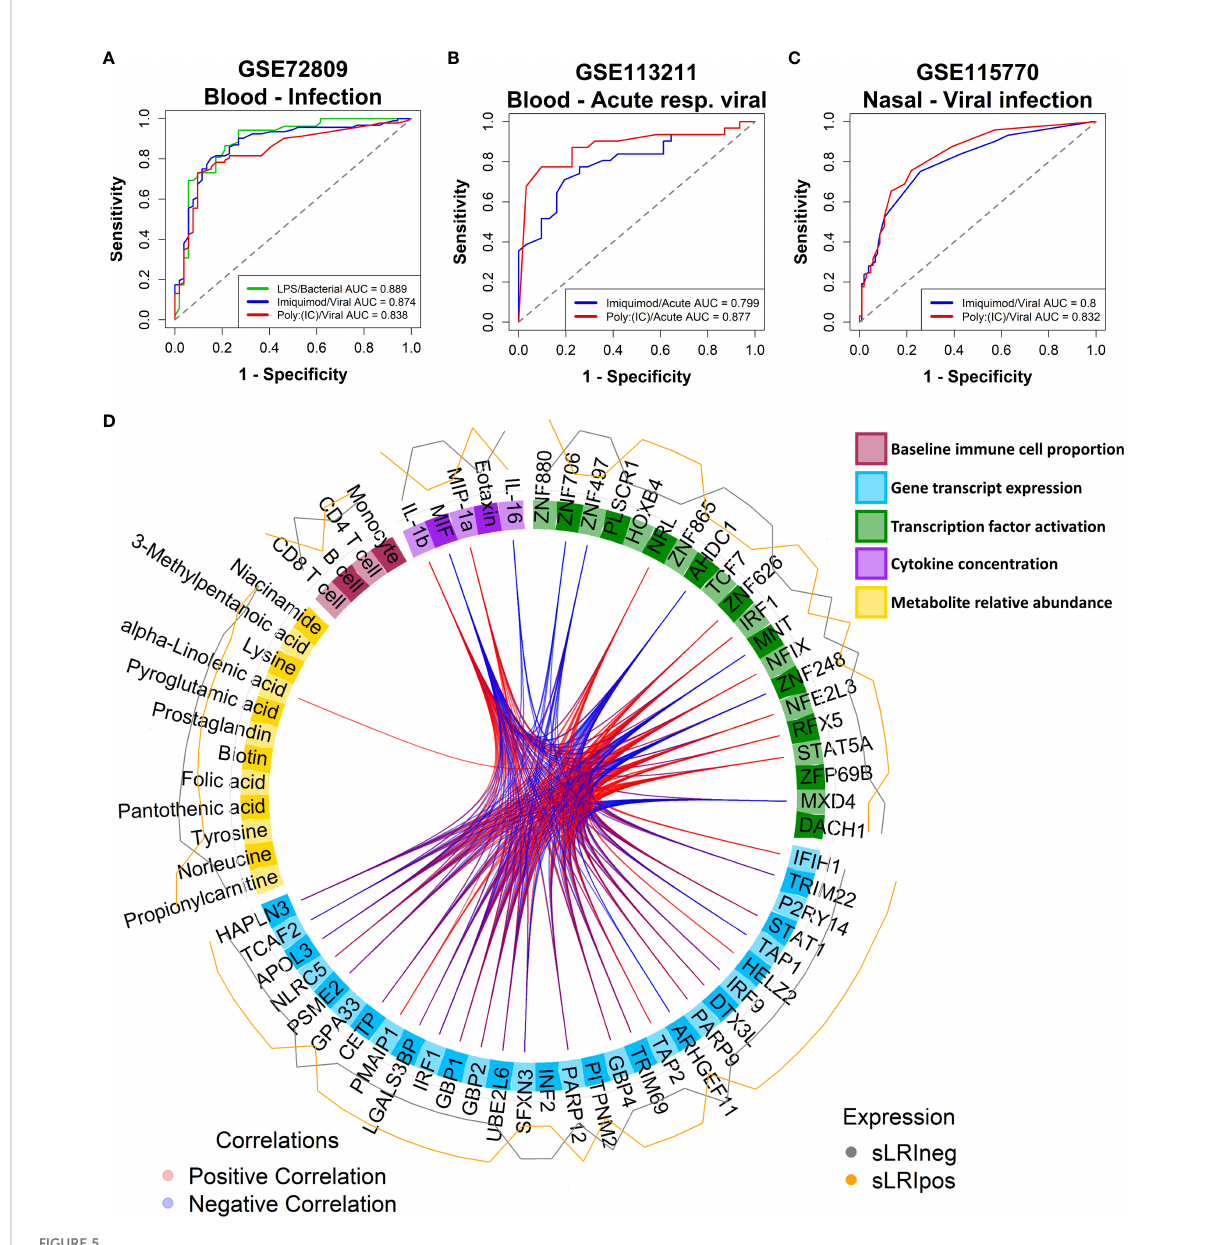
FIGURE 5 CBMC IFN responses re fl ect natural childhood response to infection; Multi-omic integration reinforces that LPS-induced IFN signalling at birth is a determinant of sLRI risk in infancy. (A) A random forest classi fi er was trained on Unstimulated and LPS or Imiquimod/Poly(I:C) CBMC IFN module gene expression data (n = 100) and used to predict children (<17yrs) hospitalized with bacterial (n = 52) and viral infections (n = 92), respectively, from healthy controls (n = 52) from blood-derived gene expression pro fi les. Gene expression data sets were restricted to available IFN module genes and RF models were optimised with respect to the number of genes and trees. Plot depicts the AUC-ROC de fi ned by the rate of false (x-axis, 1-speci fi city) and true (y-axis, sensitivity) positives. (B) RF classi fi ers trained on Unstimulated and Imiquimod or Poly(I:C) CBMC IFN module gene expression data (n=100) and used to predict PBMC gene expression pro fi les from infants (<18mo; n=15) and children (18mo-5yrs; n=16) presenting to hospital with acute viral respiratory infections from pro fi les collected during convalescence. Plot depicts the AUC-ROC. (C) RF classi fi ers trained on Unstimulated and Imiquimod or Poly(I:C) CBMC IFN module gene expression data (n=100) and used to predict asthmatic children (6-17yrs) with cold-like symptoms who do (n=193) and do not (n=105) have detectable airway viral infection from nasal-derived gene expression pro fi les. Plot depicts the AUC-ROC. (D) Circos plot displaying the multi-layer risk pro fi le for sLRI susceptibility in infancy determined from multi-omic data integration, showing between block correlation from the 1 st latent component; correlations stronger that ±0.8 are shown. Peripheral lines represent the relative expression of features from individuals who were resistant (grey) or susceptible (orange) to sLRIs in the fi rst year of life. Input data was adjusted with respect to matched unstimulated samples (except baseline immunophenotype